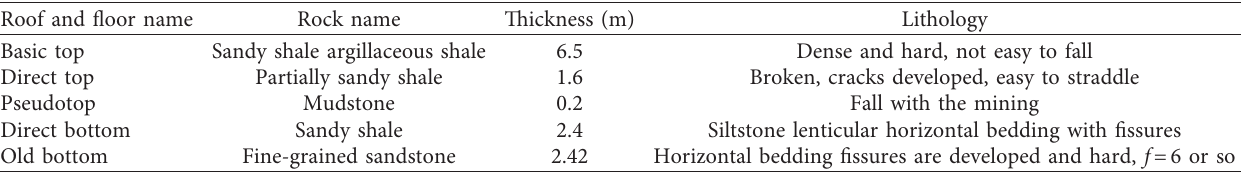
Table 1: The lithology of the roof and